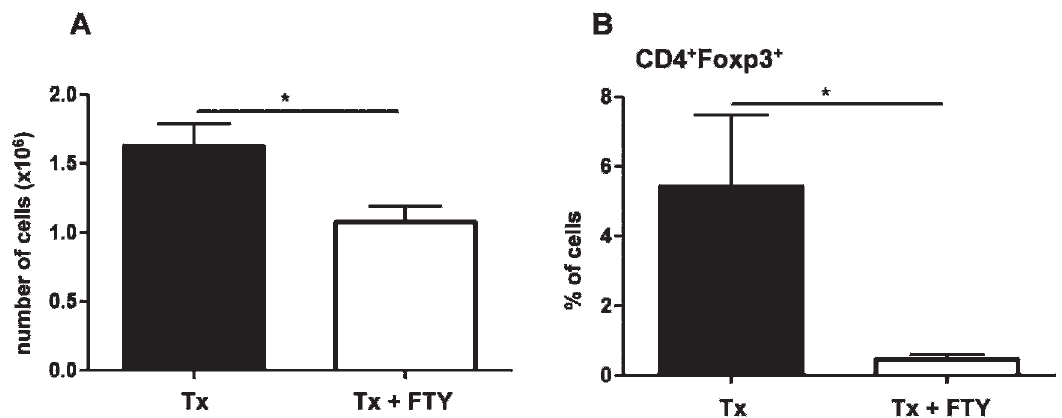
Figure 2 - Evaluation of the effect of transplantation and FTY720 treatment on draining lymph nodes (axillary) five days after F1 skin graft transplantation in the C57BL/6 mice. A - FTY720 treatment reduces the number of lymph node cells ( p =0.022). B - FTY720 treatment reduces the percentage of cells ( p =0.028) with the Treg phenotype (CD4 + Foxp3 + ). The results are expressed as the means